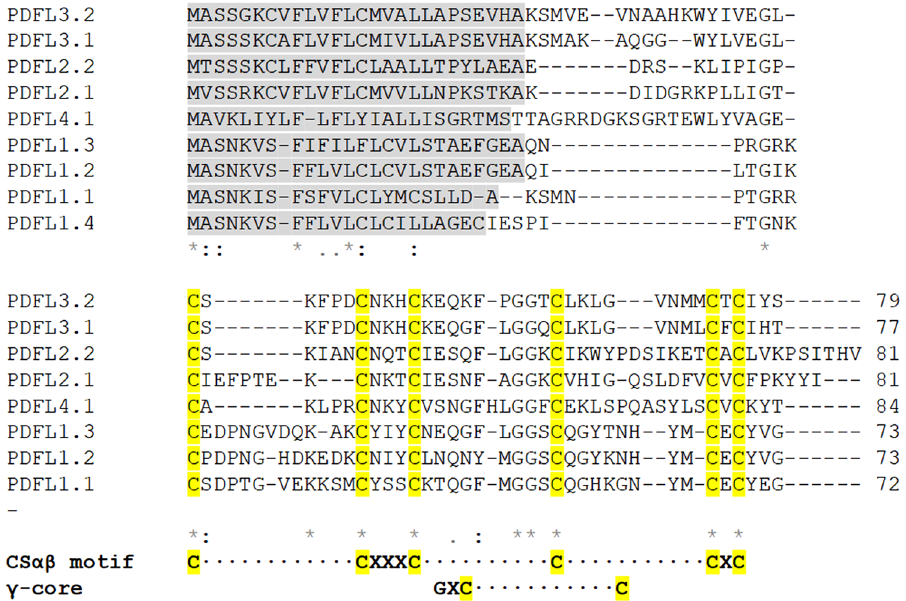
Figure 1. Multiple sequence alignment of all 9 PDFL precursor peptides. Alignment with CLUSTAL W (1.82) (http:// www. ebi. ac. uk/ Tools/ clust alw/ index. html). Symbols below the alignment are as follows: *indicates perfect alignment, : indicates strong similarity of the aligned amino acids and indicates weak similarity of the aligned amino acids. The putative signal peptide (prediction according to SignalP 4.0 Server http:// www. cbs. dtu. dk/ servi ces/ Signa lP/) is shaded and cysteines are yellow. Additional gaps have been introduced manually for better alignment. The CSαβ motif and the γ-core are shown below the sequences.